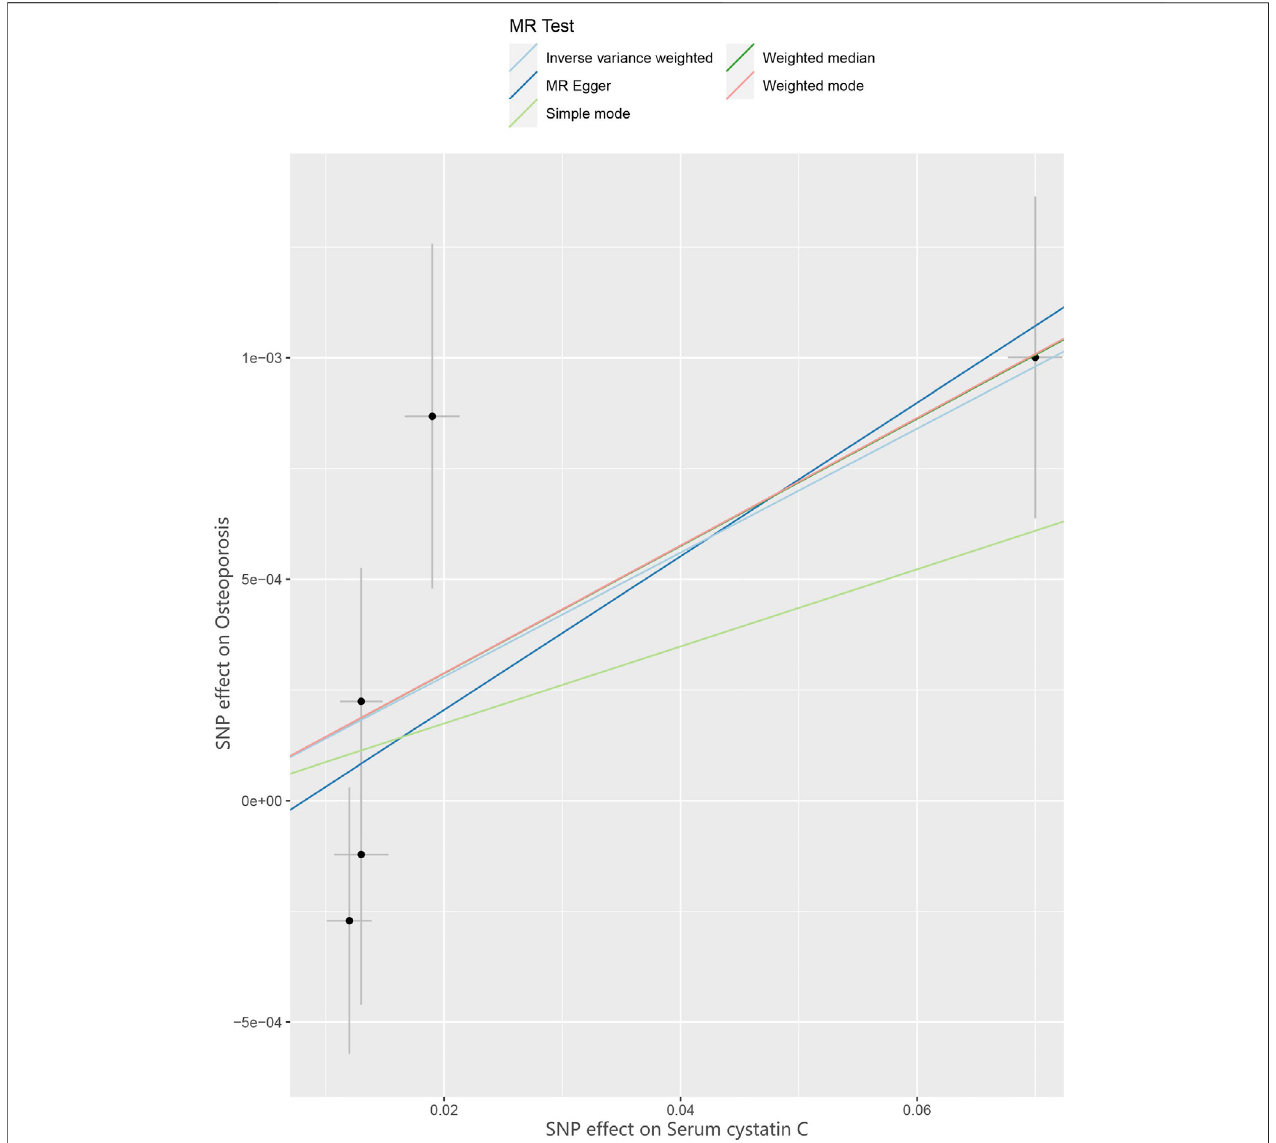
FIGURE2| ScatterplottovisualizecausaleffectofCystatinConosteoporosisrisk.Theslopeofthestraightlineindicatesthemagnitudeofthecausalassociation. IVW indicates inverse-variance weighted; and MR, Mendelian randomization.